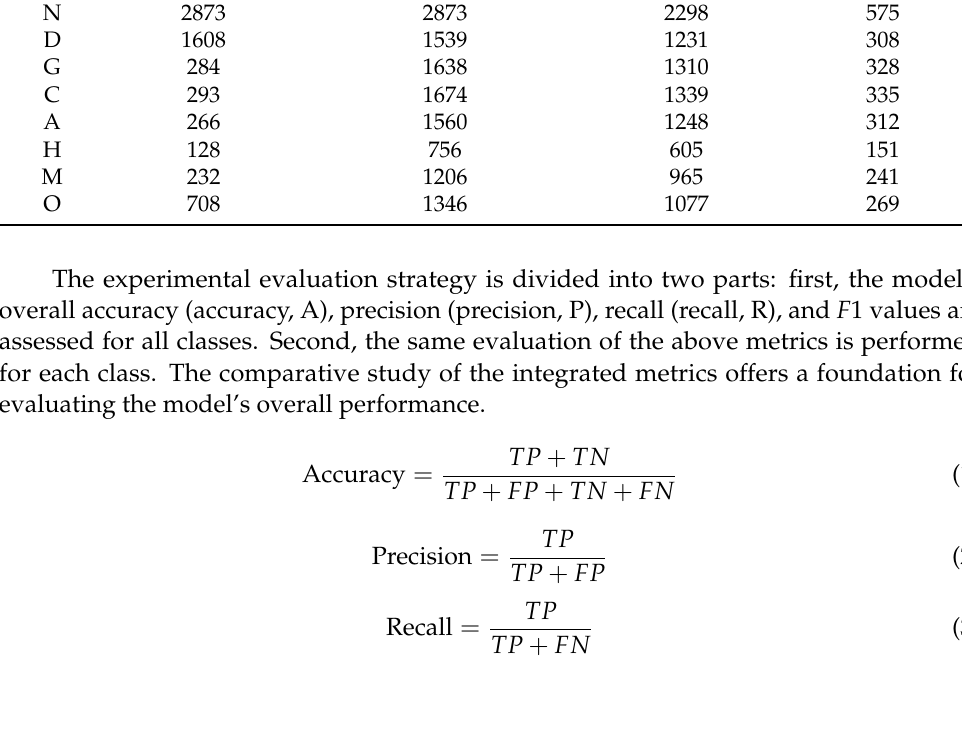
Table 1. Sample distribution after image preprocessing.